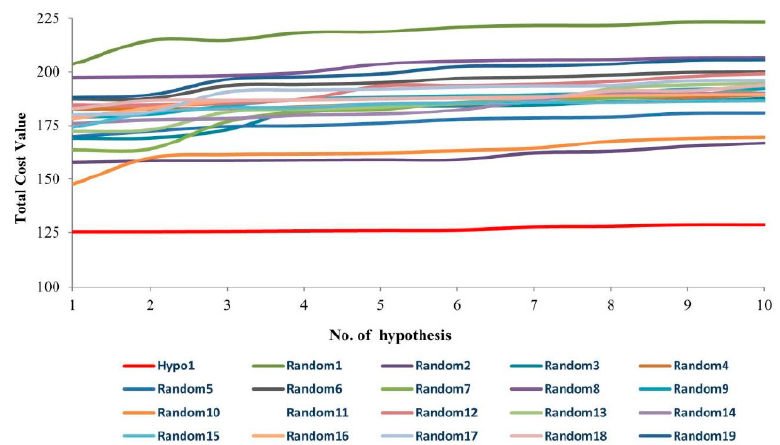
Figure 3. A graphical representation of the total cost values of Hypo1 and each of the 10 hypotheses generated from 19 random spreadsheets during Fischer’s randomization run. A confidence level of 95% was used. Hypo1 obtained the lowest total cost value.